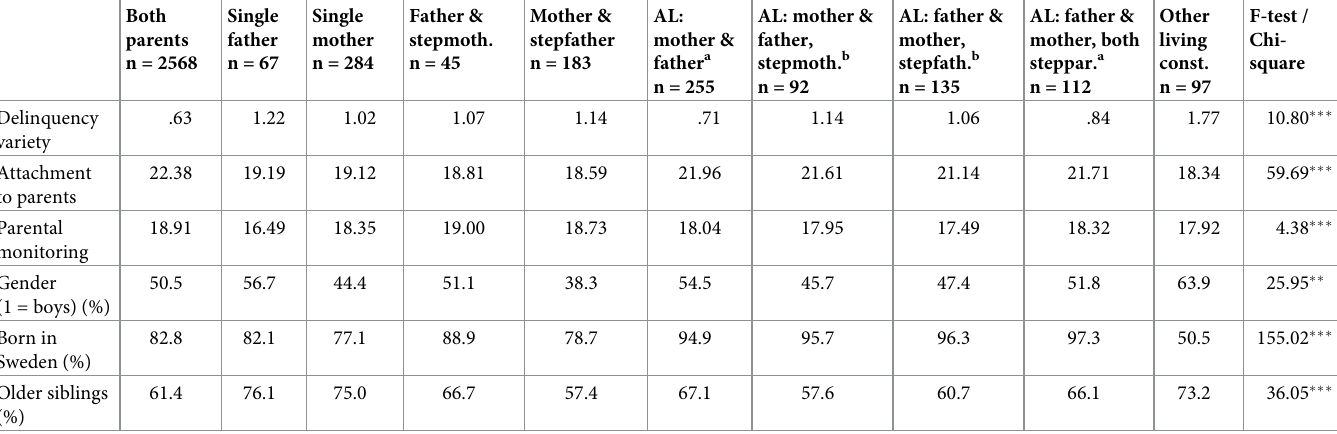
Table 2. Means/proportions of variables by family structure (N =